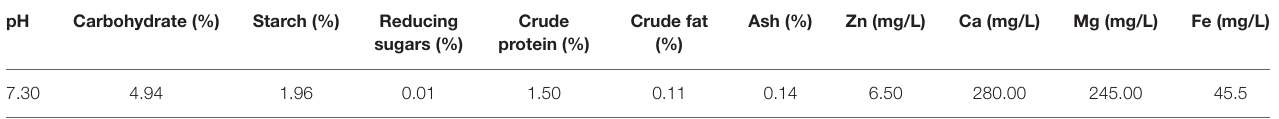
TABLE 2 | Chemical composition of wastewater from potato chips manufacturing. pH Carbohydrate (%)